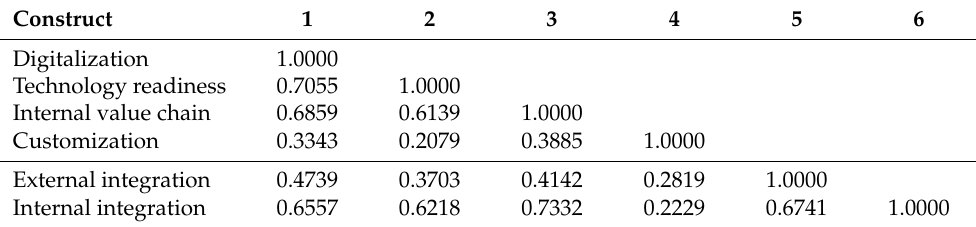
Table 3. Inter-construct